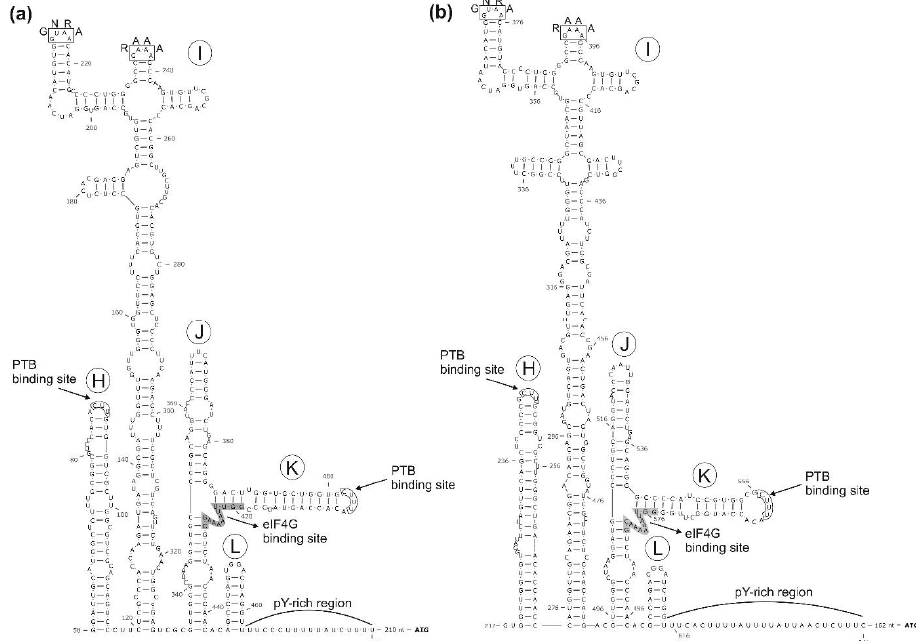
Figure 3. The predicted secondary RNA structures of 5 ′ UTR-IRES core domains (H–L) of ovipivirus ( a ) and bopivirus/Hun ( b ). Numbers indicate the nucleotide positions in the complete genome of the given virus. PTB: Polypyrimidine tract-binding protein, eIF4G: Eukaryotic translation initiation factor 4 G, pY: polypyrimidine (C or U), ATG : Start codon.